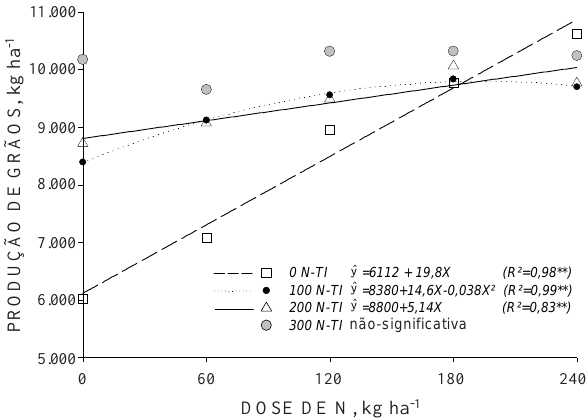
Figura 5. Produtividade de grãos de milho de acordo com as doses crescentes de N aplicadas no verão (N-TV) e no inverno (N-TI), Guarapuava (PR) 1999/2000.